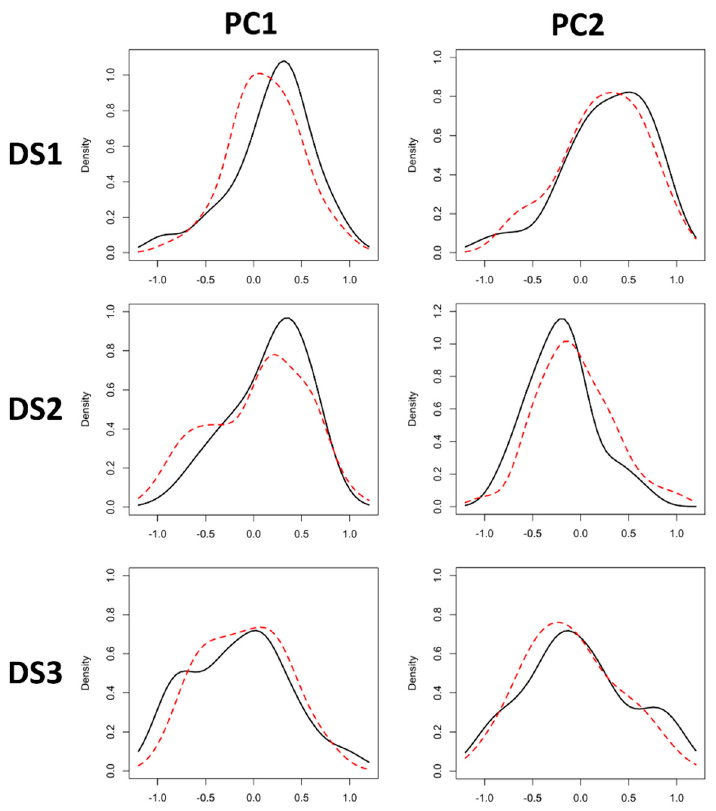
Figure 7. Plots of distributions both before (black) and after (red) GAN data augmentation, using the best performing models as described in Table 3. Descriptive statistics for each are included in Tables S2, S4 and S6.